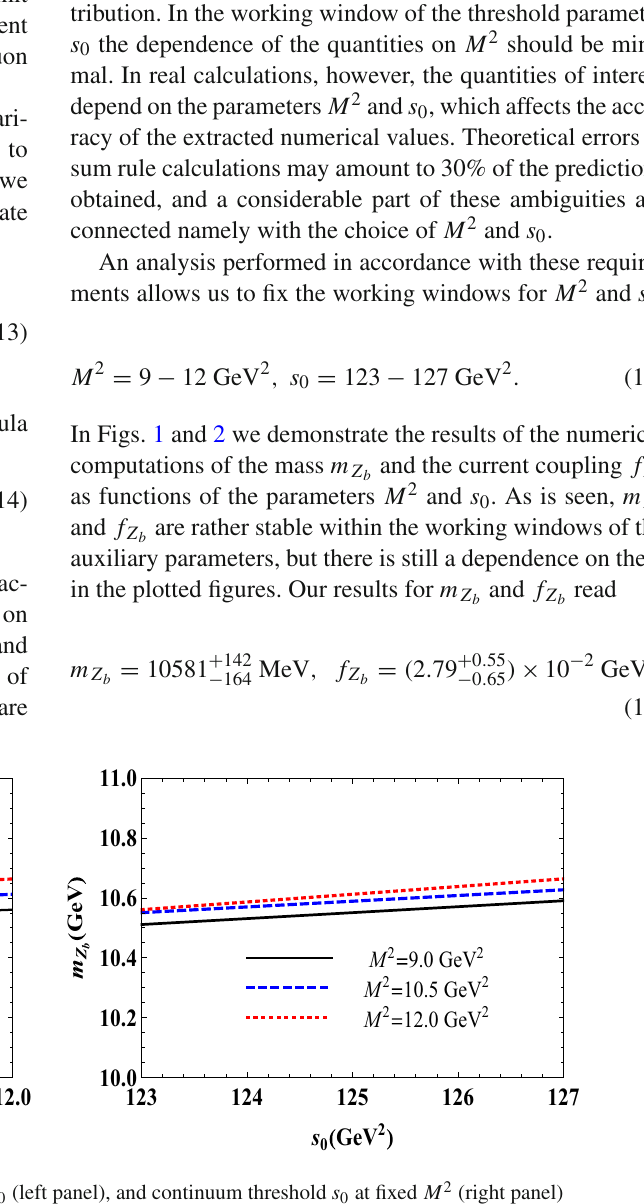
Fig. 1 The mass of the Z b state vs. Borel parameter M 2 at fixed s 0 (left panel), and continuum threshold s 0 at fixed M 2 (right